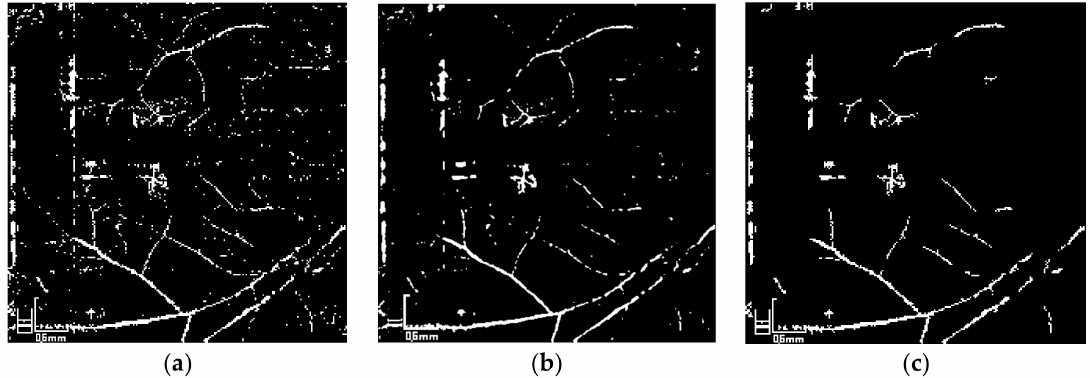
Figure 5. An example of clear blood vessel detection: ( a ) Otsu’s method; ( b ) Majority; ( c ) Size